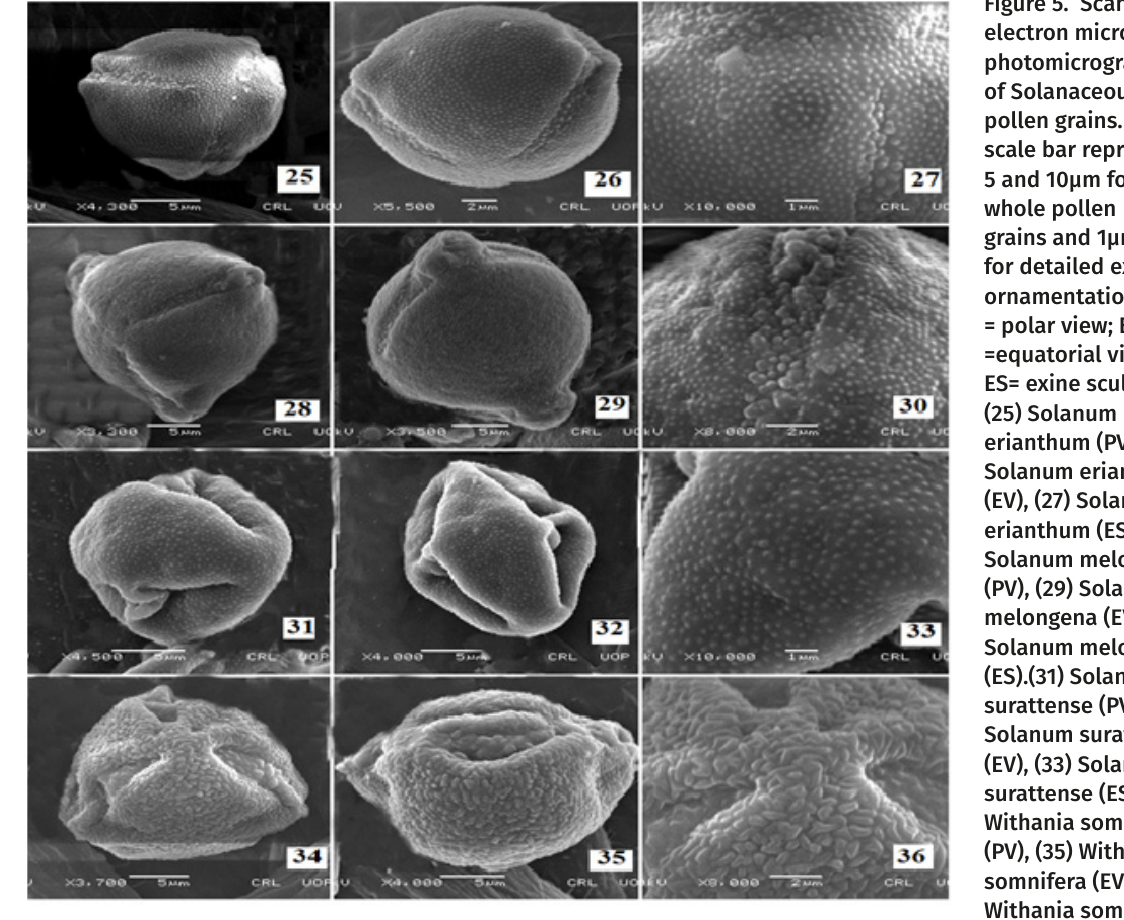
Figure 5. Scanning electron microscope